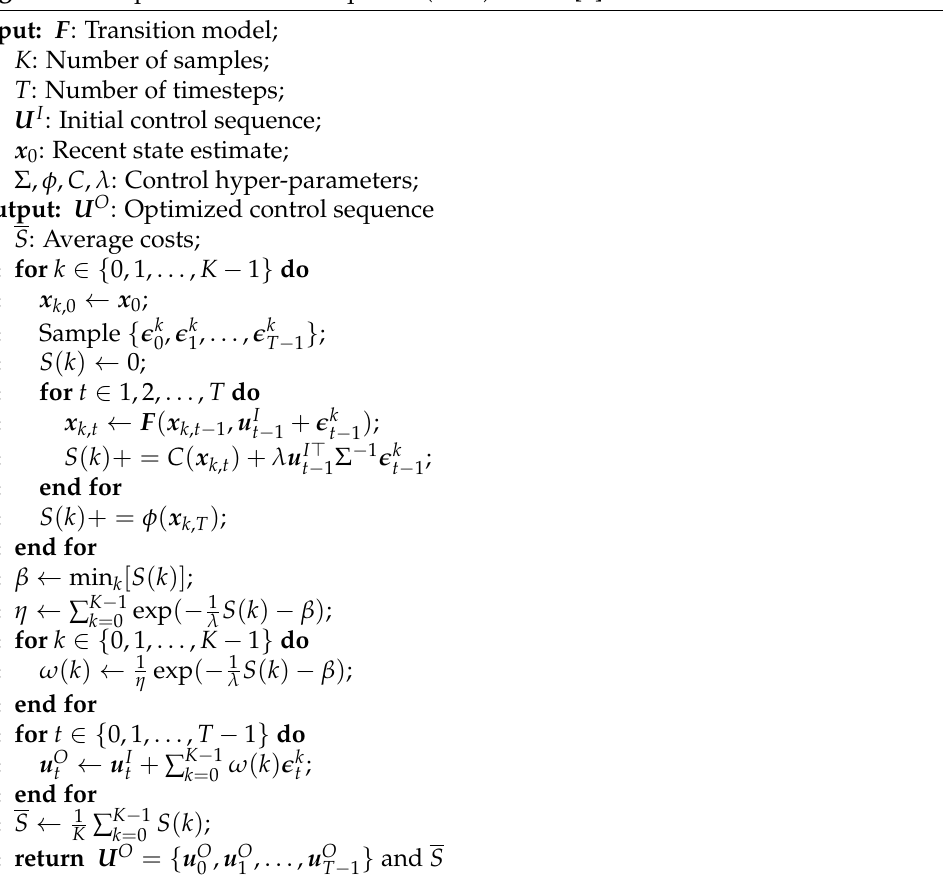
Algorithm 1 Optimize Control Sequence (OCS) acc. to